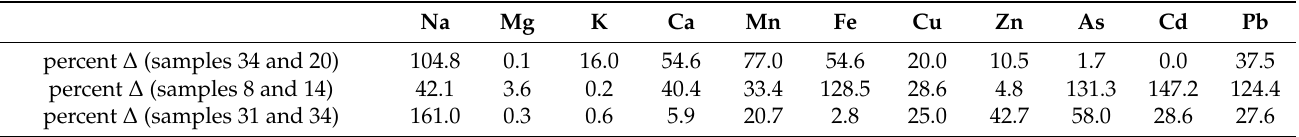
Table 1. Percent difference between selected sample sites.